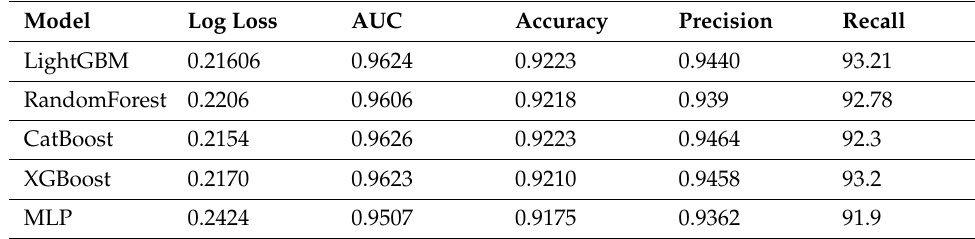
Table 3. Metrics comparison between the trained models. Model Log Loss AUC Accuracy